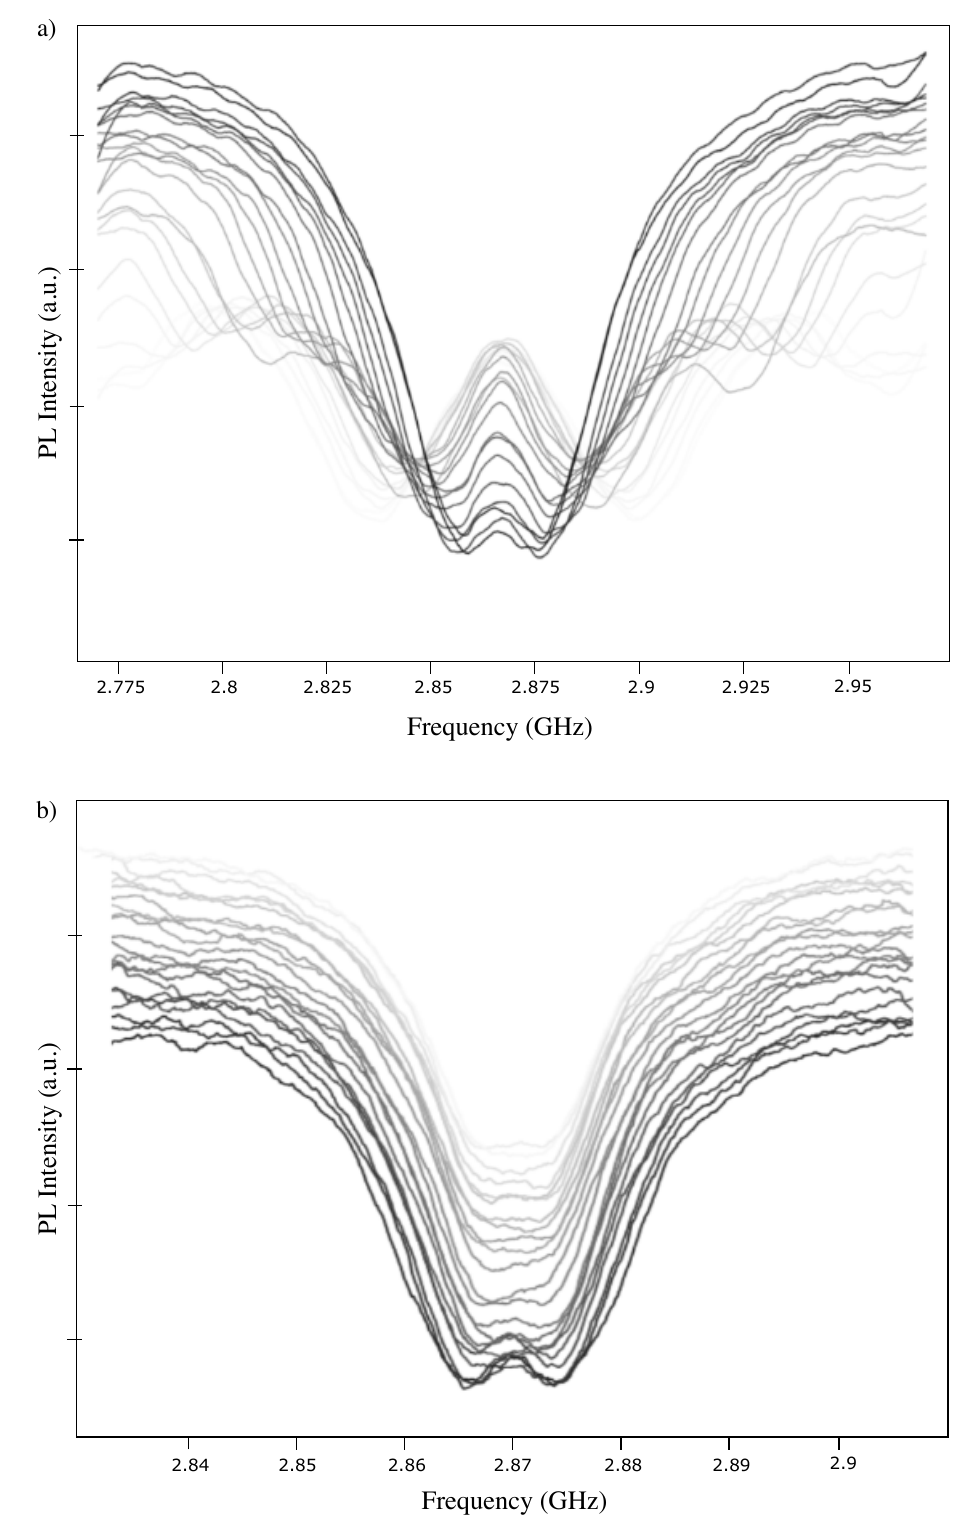
Figure 9. Experimental measurement of photoluminescence as a function of the magnetic field for frequencies in the range of 2.7 to 3 GHz where it is observed how the gap between the resonance holes grows when the magnetic field increases. ( a ) is obtained by using the described electromagnet, changing the voltage and ( b ) is the result of the characterization moving the permanent magnet away at each